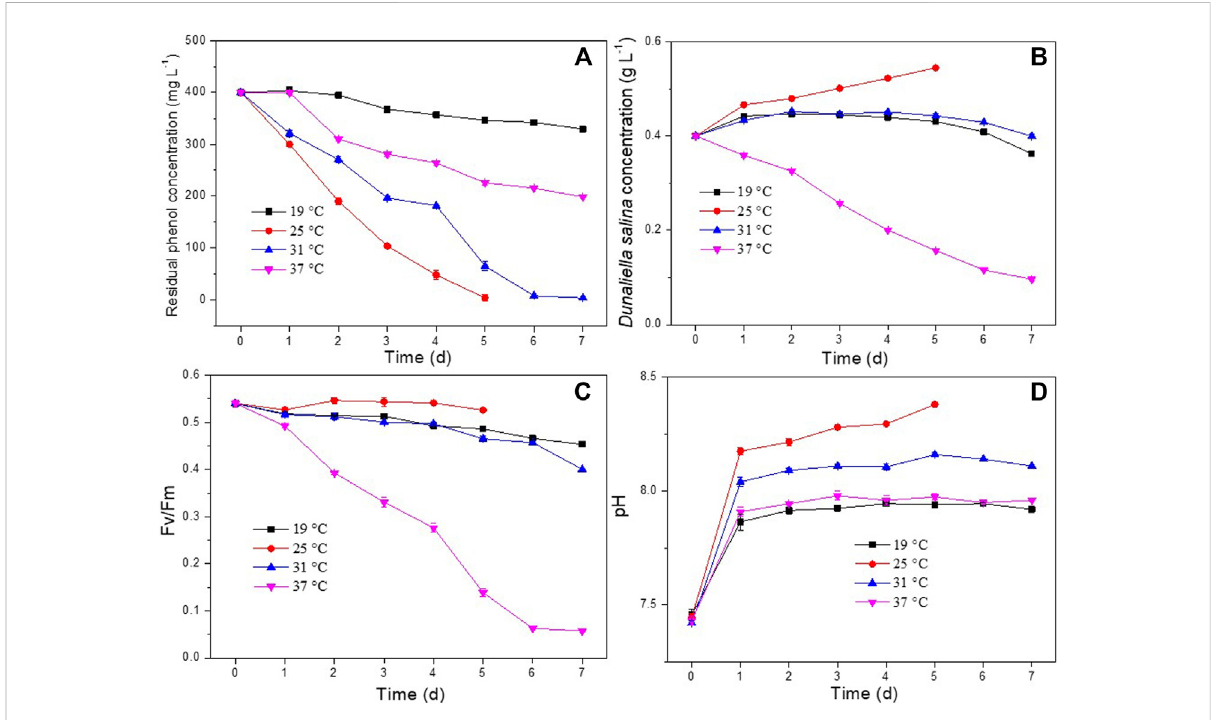
(Figure 4C) under 360 μ mol m − 2 s − 1 .The changes of pH